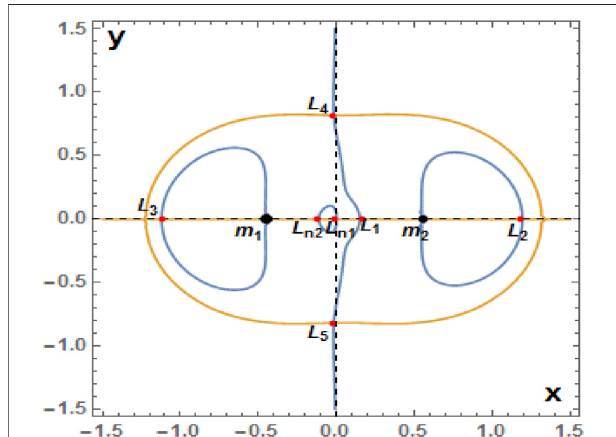
FIGURE 2 | Plots of U x = 0 ( blue curves ) and U y = 0 ( orange curves ) depicting the locations of the seven equilibrium points ( red dots ) on the x y – plane for μ = 0.4583, M b = 0.05, σ 1 = 4 × 10 − 5 , σ 2 = 3 × 10 − 5 , σ 3 = 2 × 10 − 5 , σ